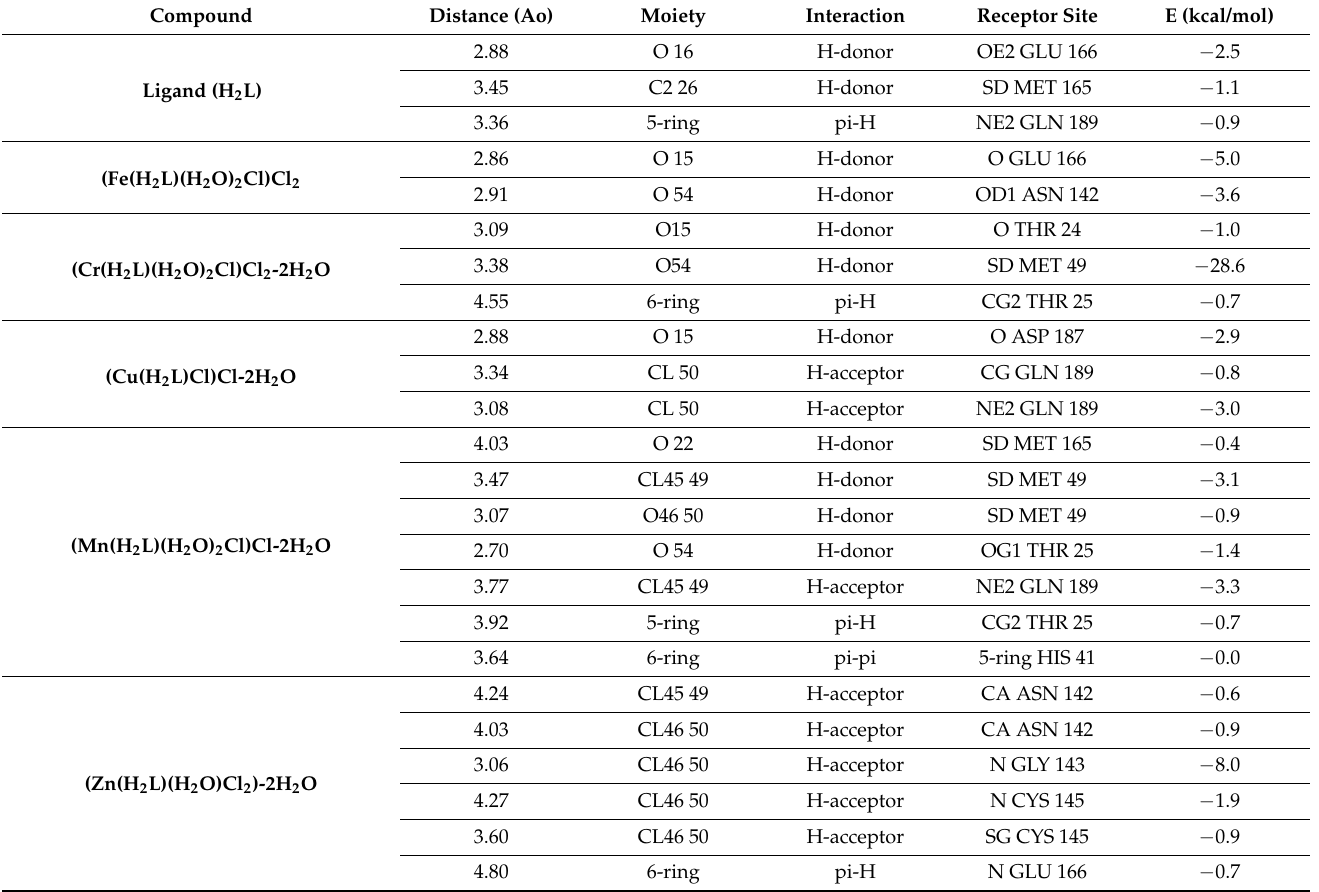
Table 4. Docking calculations of H2L and its metal complexes with to Crystal structure of the SARS-CoV-2 (COVID-19) primary protease in complex with inhibitor UAW247 (6XBH). Compound Distance (Ao) Moiety Interaction Receptor